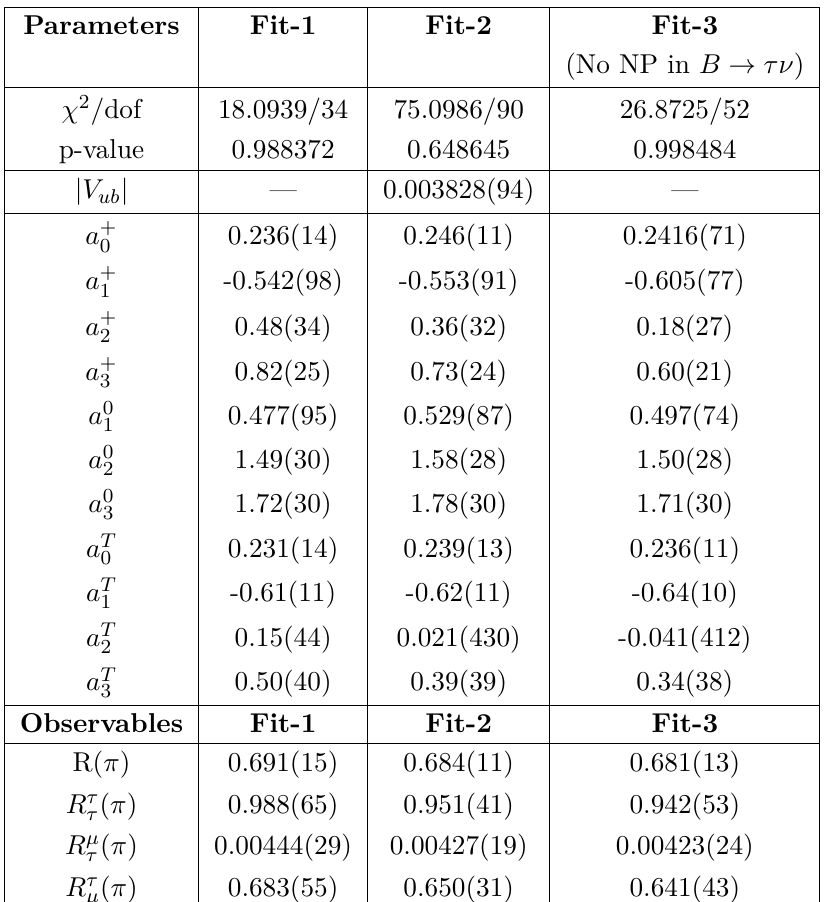
for the form factors f i ( q 2 ) that n ’s do not 0